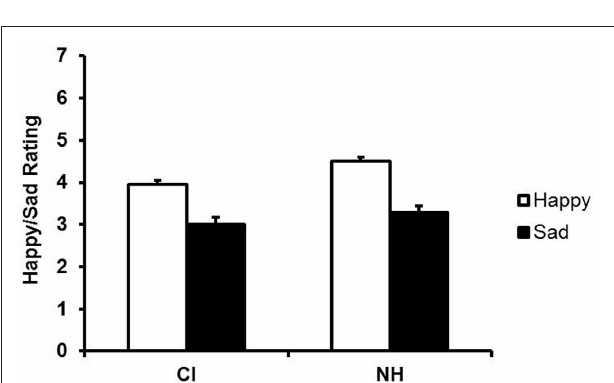
FIGURE 3 | Mean ratings of the low-pass filtered imitations (i.e., content unintelligible) of child CI users and NH children as happy- or sad-sounding. Error bars indicate standard